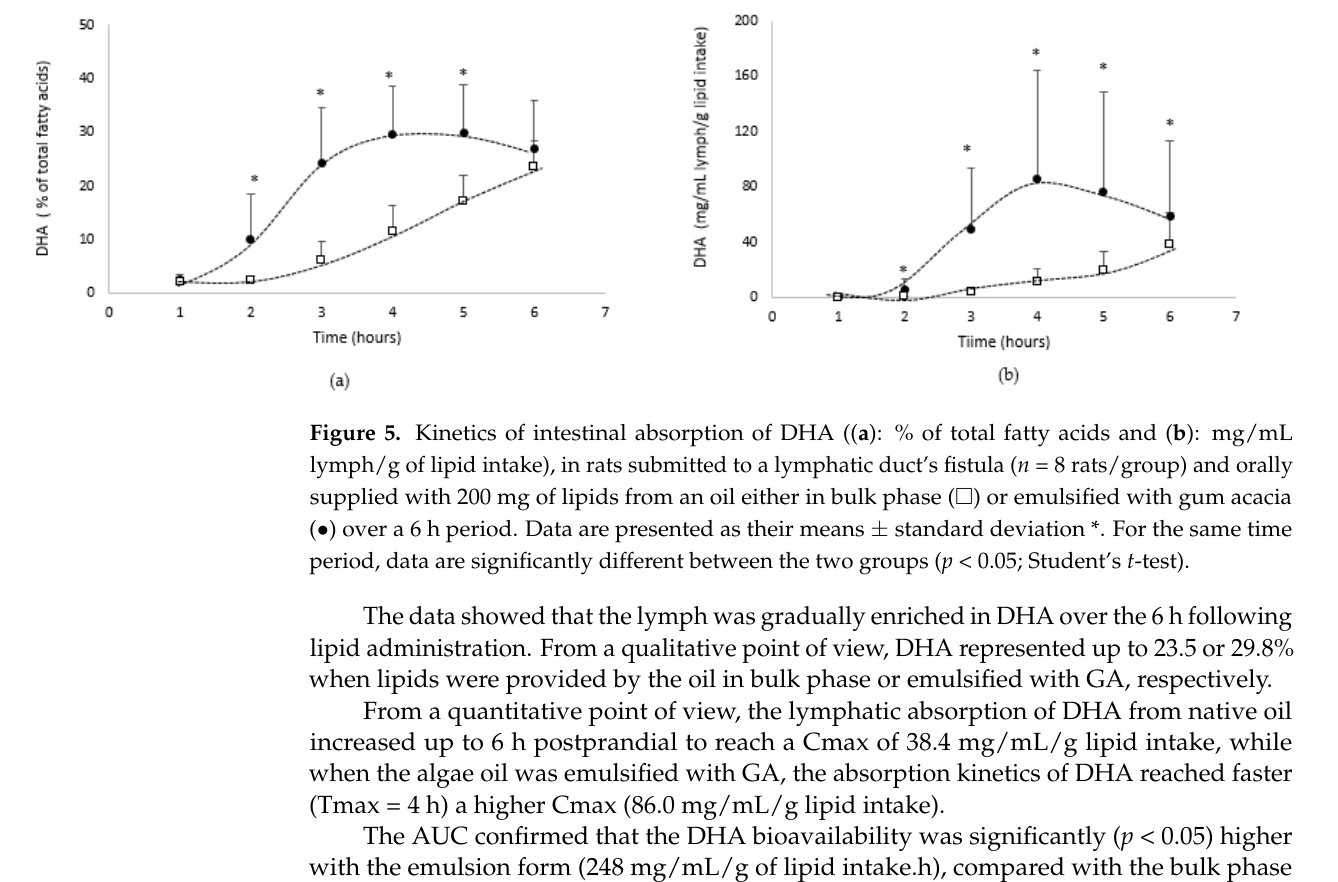
9 of 17 Figure 4. Kinetics of intestinal absorption of EPA (( a ): % of total fatty acids and ( b ): mg/mL lymph/g of lipid intake), in rats submitted to a lymphatic duct’s fistula ( n = 8 rats/group) and orally supplied with 200 mg of lipids from an oil either in bulk phase ( (cid:0) ) or emulsified with gum acacia ( • ) over a 6 h period. Data are presented as their means ± standard deviation *. For the same time period, data are significantly different between the two groups ( p < 0.05; Student’s t -test). The data showed that lymph was gradually enriched in EPA over the 6 h following lipid administration. From a qualitative point of view, EPA represented up to 0.85% or 1% when lipids were provided by the oil in bulk phase or emulsion with GA, respectively. From a quantitative point of view, the lymphatic absorption of EPA from native oil increased up to 6 h postprandial to reach a Cmax of 1.3 mg/mL/g lipid intake, while when oil was emulsified with GA, the absorption kinetics of n-3 PUFA reached faster (Tmax = 4 h) a higher Cmax (2.8 mg/mL/g lipid intake). The AUC confirmed that the EPA bioavailability was significantly ( p < 0.05) higher with the emulsion form with GA (8.6 mg/mL/g of lipid intake.h), compared with the bulk phase form of the oil (2.5 mg/mL/g of lipid intake.h).